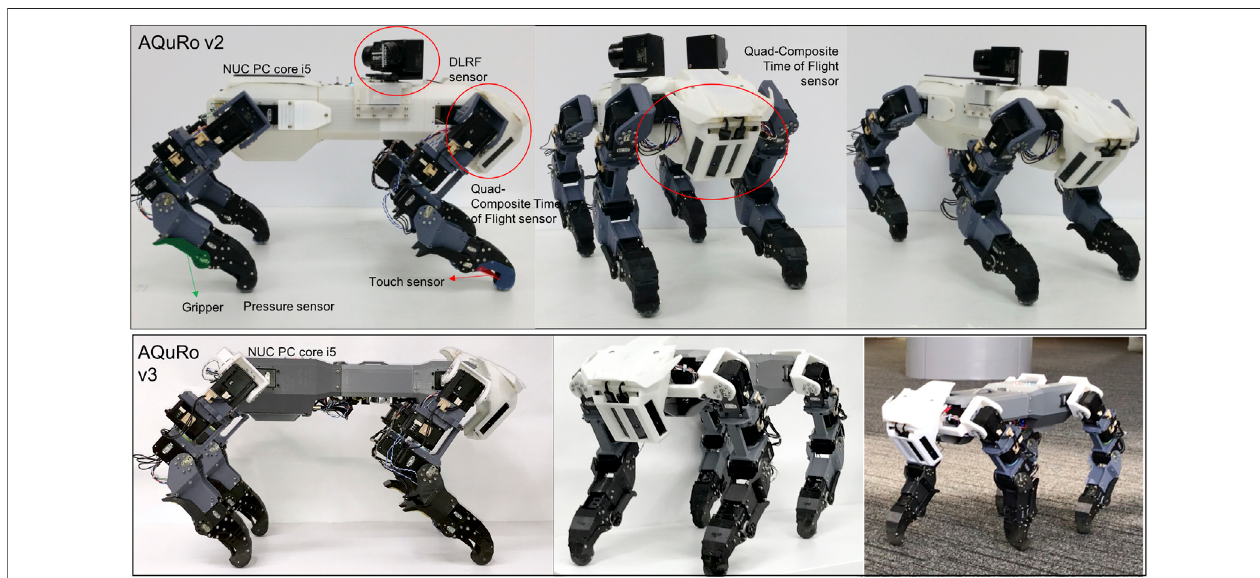
FIGURE 1 | The quadruped robot. AQuRo v2 is attached with DLRF sensor and AQuRo v3 has slimmer body without DLRF sensor.